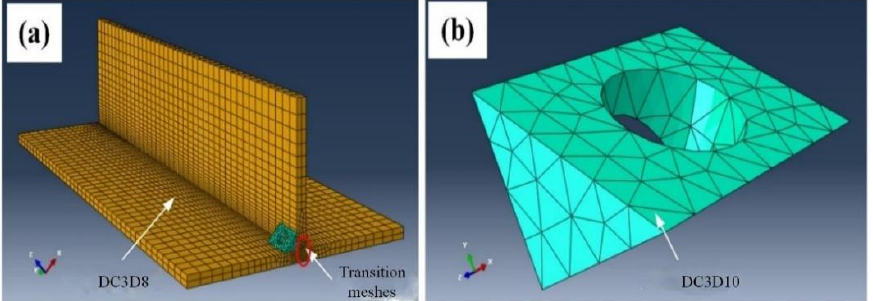
Figure 1. Mesh generation results of the geometrical model: ( a ) meshed material to be welded; ( b ) meshed stationary shoulder.